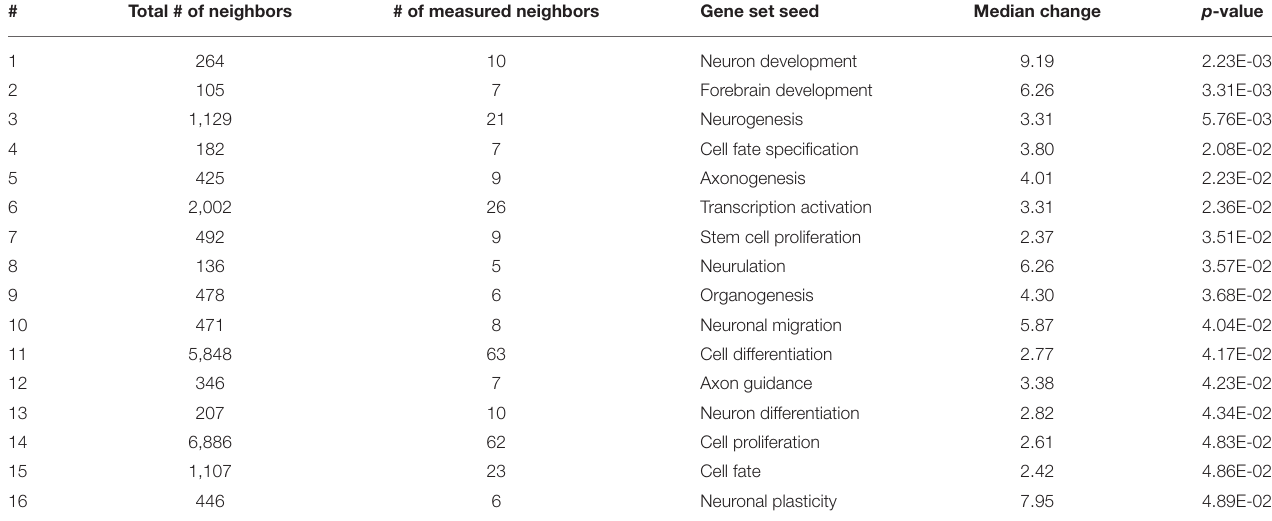
TABLE 5 | Selected subnetwork enrichment pathways for the